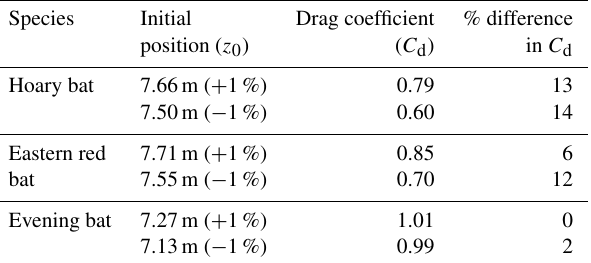
Table 3. Optimal filtering window, initial position, drag coefficient, and terminal velocity.